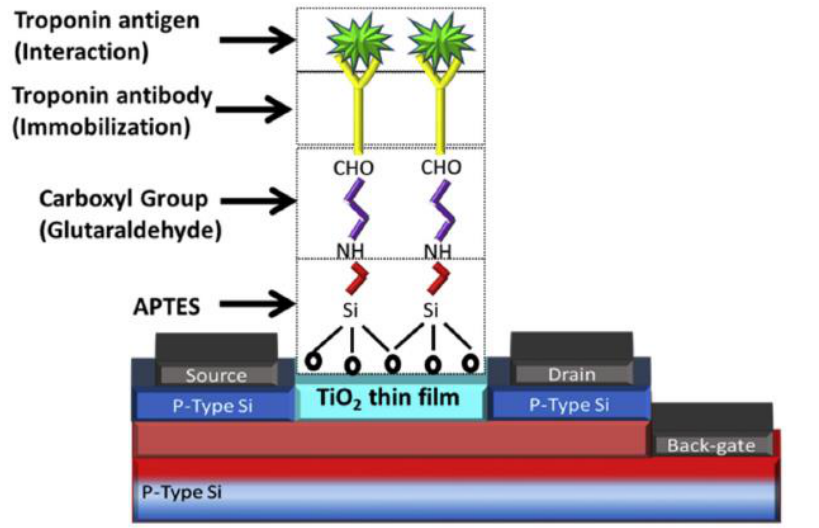
Figure 1. Illustration of FET –based immunosensor depicting the immobilisation strategy [66] (Figure wasre-printed with permission from the publisher). printed with permission from the